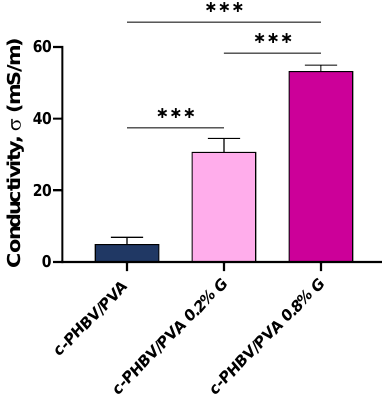
Figure 9. Electrical surface conductivity of the semi-IPNs with and without graphene nanosheets. Graph shows mean ± standard deviation; (***) indicates significant differences ( p < 0.001).